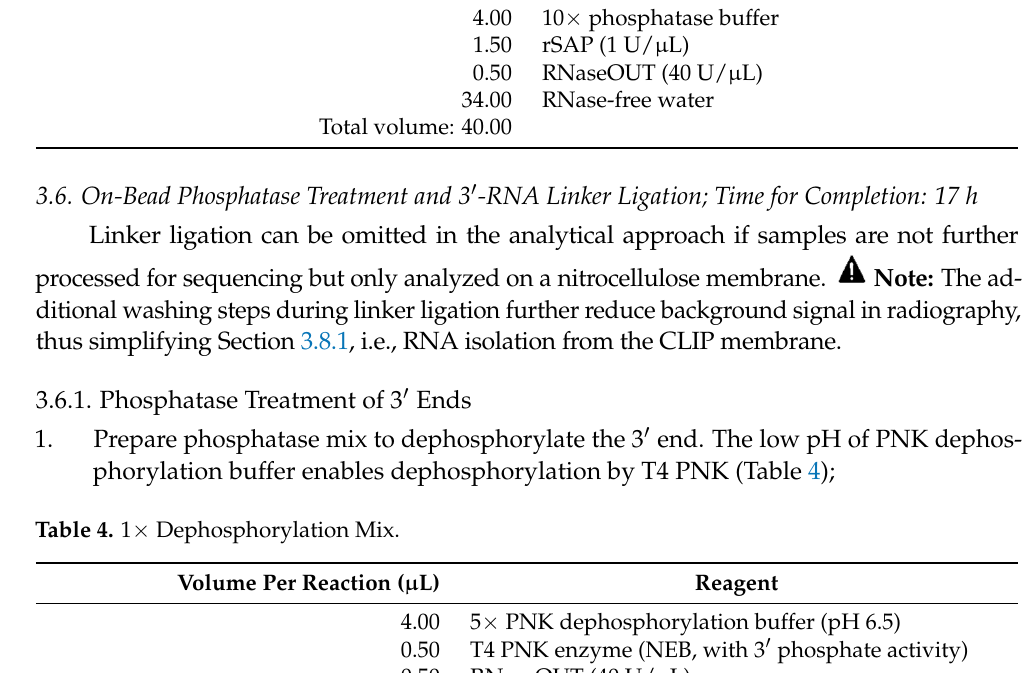
Table 7. RNA-Primer Mix for Reverse Transcription.